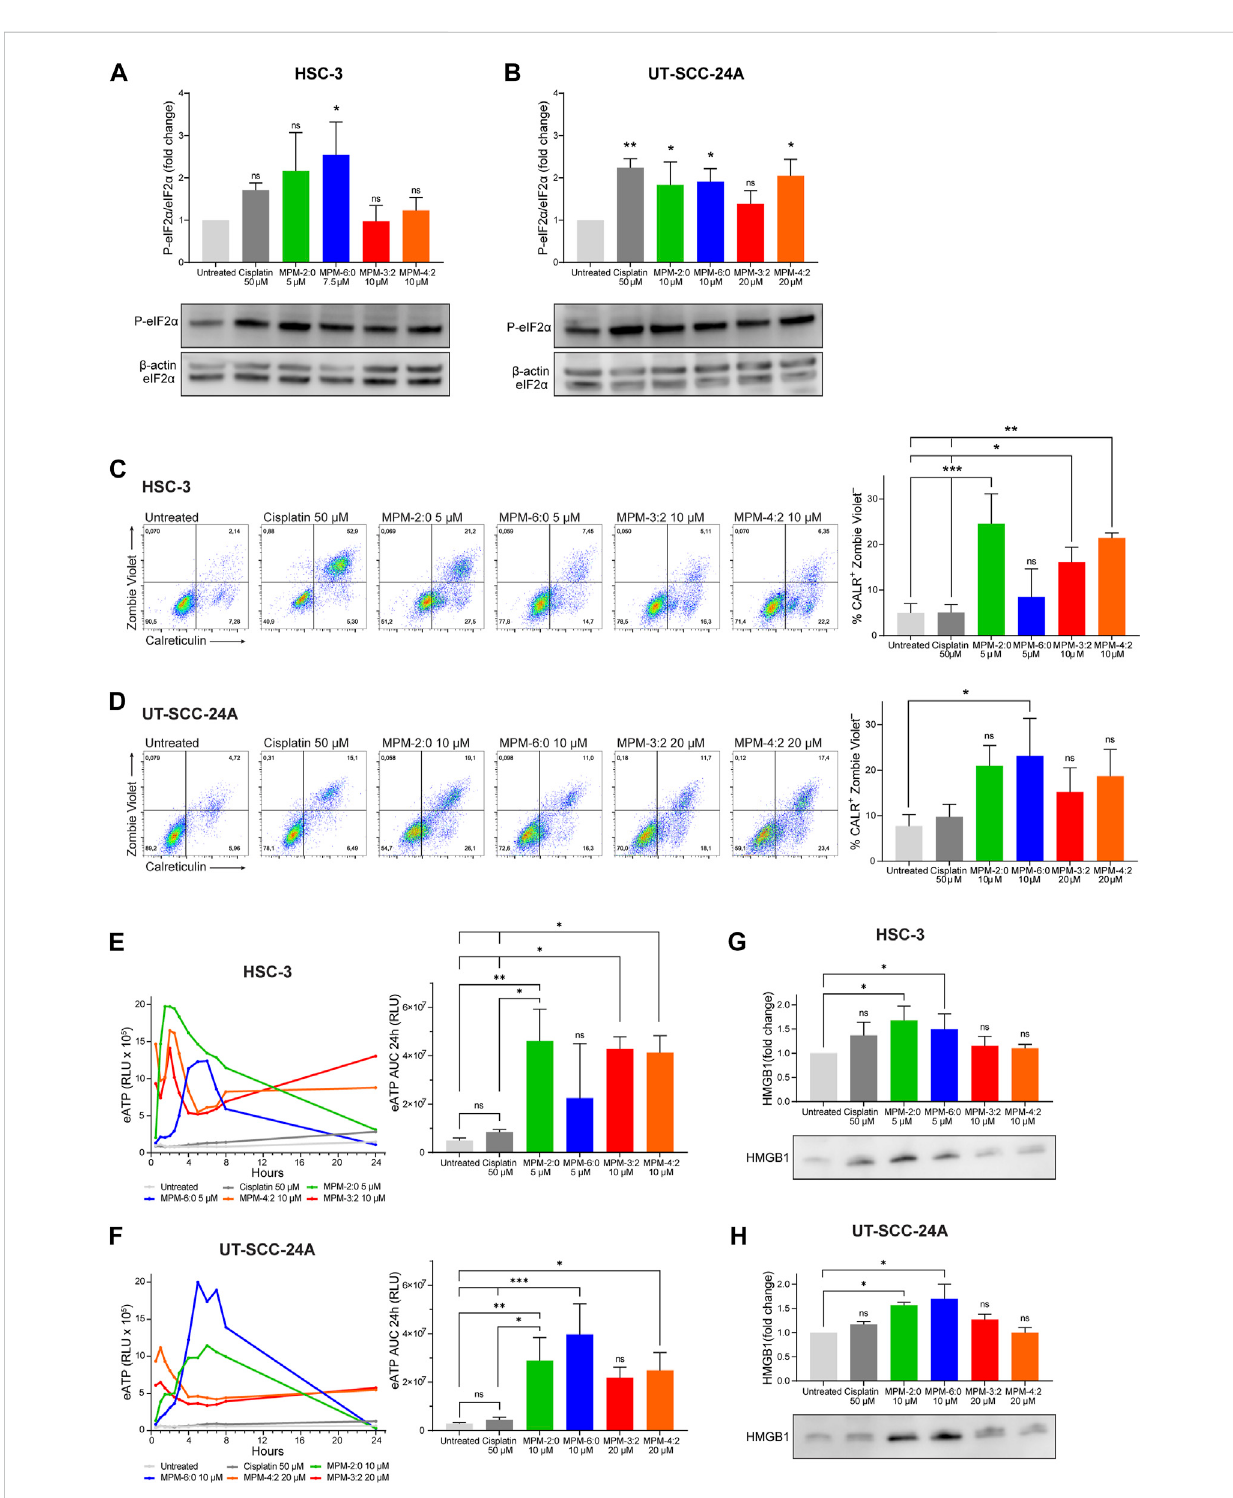
FIGURE 5 The phosphorylation of eIF2 α in HSC-3 (A) and UT-SCC-24A (B) cells treated with MPMs was analyzed by Western blot. Band intensities were quanti fi edandnormalizedtonon-phosphorylatedeIF2 α .Thecellsurfaceexpressionofcalreticulinwasanalyzedby fl owcytometryinHSC-3 (C) andUT- SCC-24A (D) cells treated with MPMs. The percentage of live cells expressing calreticulin (Zombie Violet – /CALR+) was determined and the graph shows themeanfromthreeindependentexperiments.Statisticaldifferencesweredeterminedbyone-wayANOVAandBonferroni ’ s posthoc .Extracellular ATP (eATP) was measured in the supernatant of MPM treated HSC-3 (E) and UT-SCC-24A (F) cells by means of a luminescence-based assay at several time points over the course of 24 h. The amount of eATP is proportional to the relative luminescence units (RLU). Three independent experiments were performed. The area under the curve (AUC) was calculated and statistical analysis was performed by one-way ANOVA and Bonferroni ’ s post hoc . HMGB1inthesupernatantofuntreatedandMPMtreatedHSC-3 (G) andUT-SCC-24A (H) wasanalyzedbyWesternblot.Bandintensitieswerequanti fi ed and normalized to the untreated sample. Statistical analysis was performed by Kruskal – Wallis test and Dunn ’ s post hoc